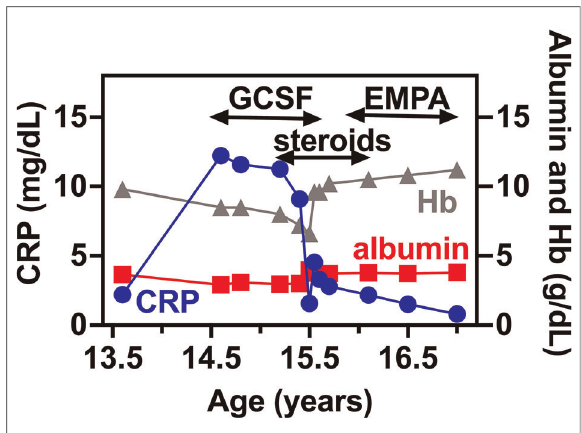
FIGURE 2 IBD related biomarkers for PT1. CRP, serum albumin and hemoglobin levels are shown in relation to PT1 IBD disease course. In speci fi c, GCSF, systemic steroids and EMPA treatment are shown as upper